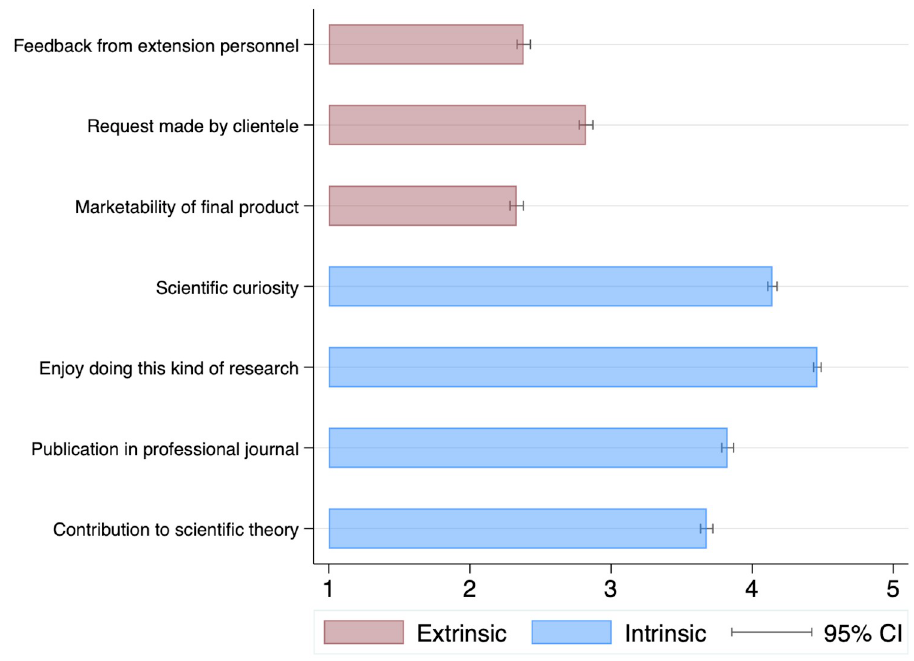
Fig 2. Average per motivation item, from 1989 to 2015. Figure displays cross-year average per item, with 95 percent confidence intervals. N =